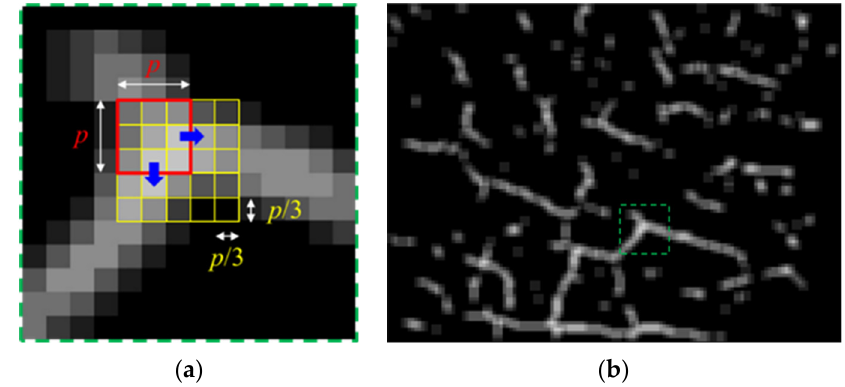
Figure 6. ( a ) Stride of a square region for cropping images; ( b ) crack detection result.